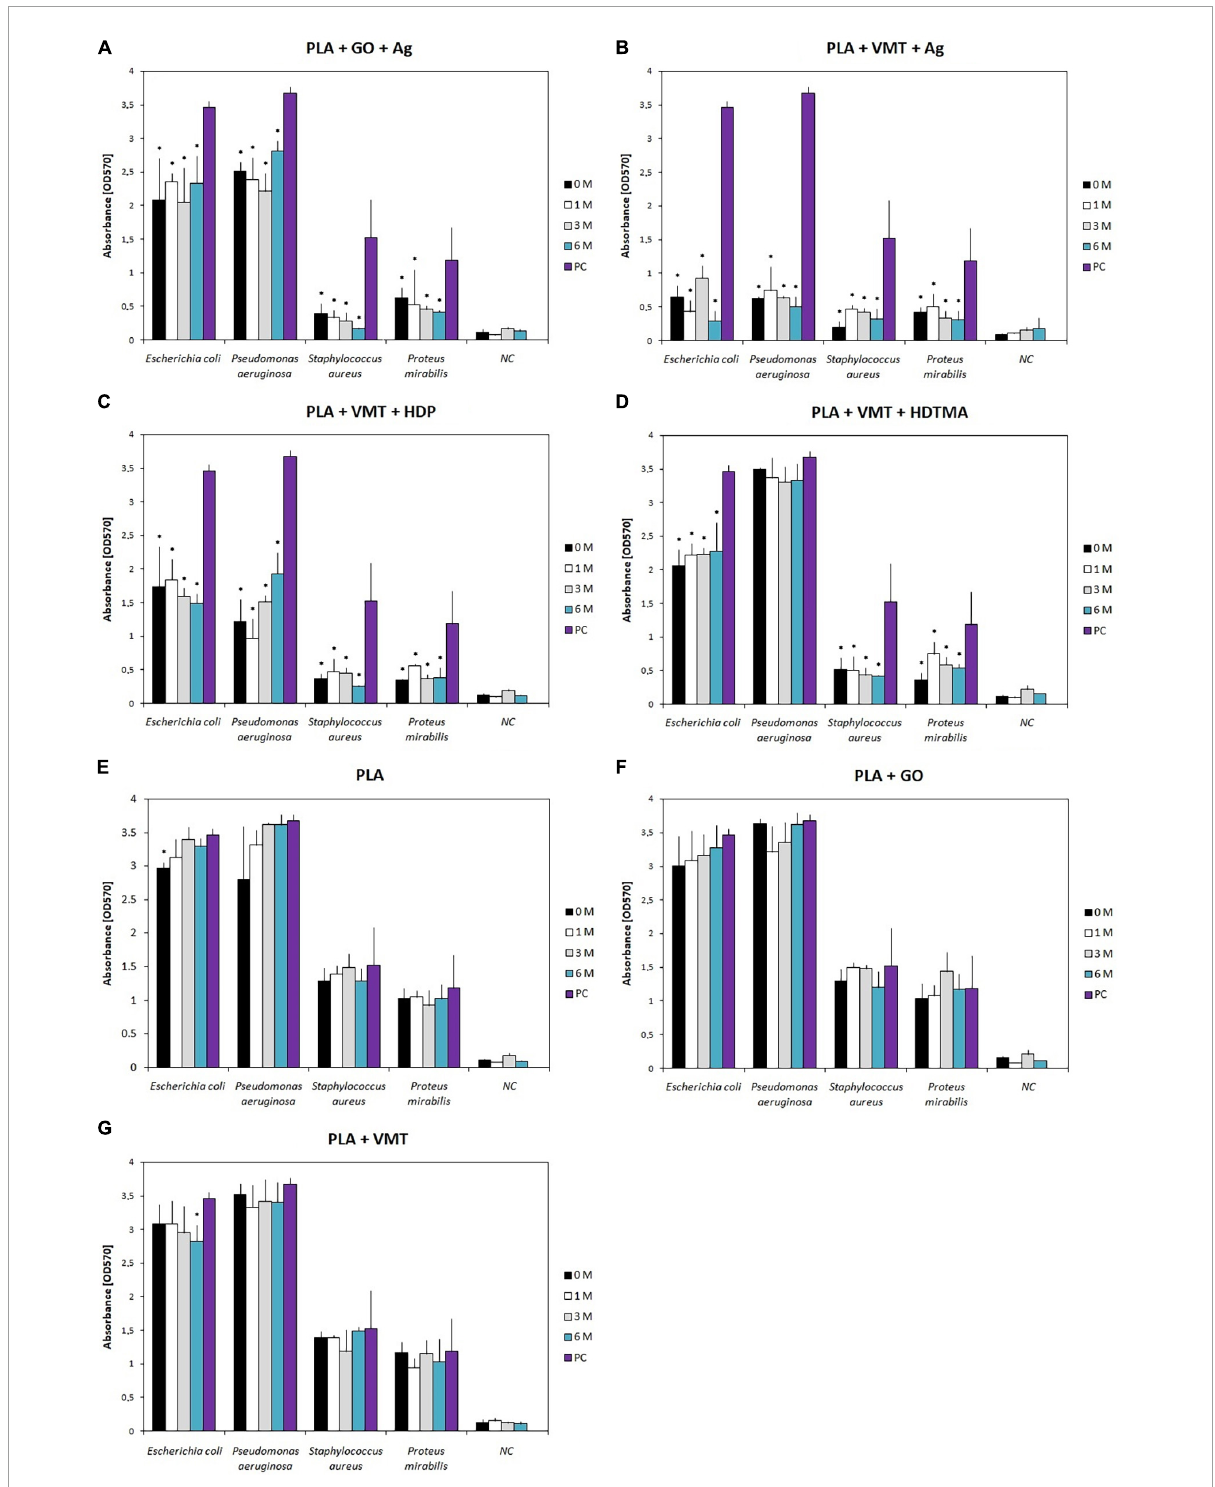
FIGURE2 Influence of polylactide composite PLA + GO + Ag (A) , PLA + VMT + Ag (B) , PLA + VMT + HDP (C) , PLA + VMT + HDTMA (D) , PLA (E) , PLA + GO (F) , and PLA + VMT (G) on the biofilm formation after 0, 1, 3 and 6 months of degradation of composites in saline solution. Absorbance measured after 24 h incubation at 570 nm. NC, negative control, composite sample in nutrient medium without microbial strain, PC, positive control, microbial strain in nutrient medium, M, month (time of degradation). ∗ Indicates a significant statistical difference ( p < 0.05) between the microbial strain affected by the sample and the positive